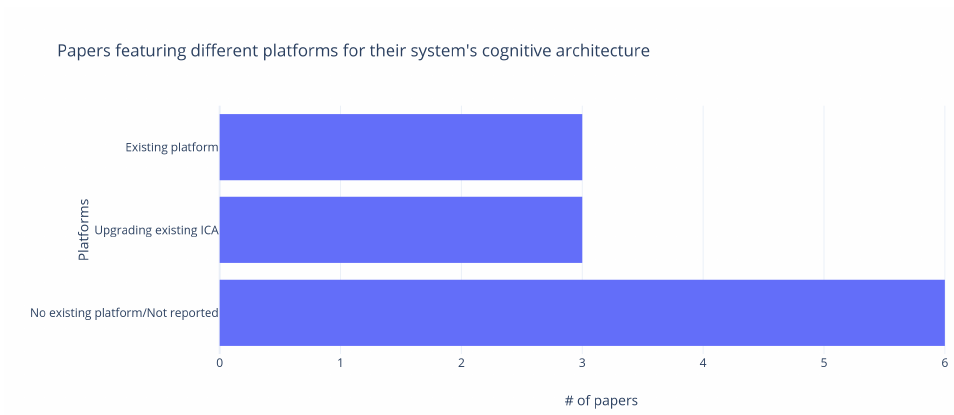
Figure 6. Papers featuring different platforms for their system’s cognitive architecture. “Upgrading existing ICA” denotes using existing instances of architectures and upgrading them (e.g., ELIZA [116,118]).